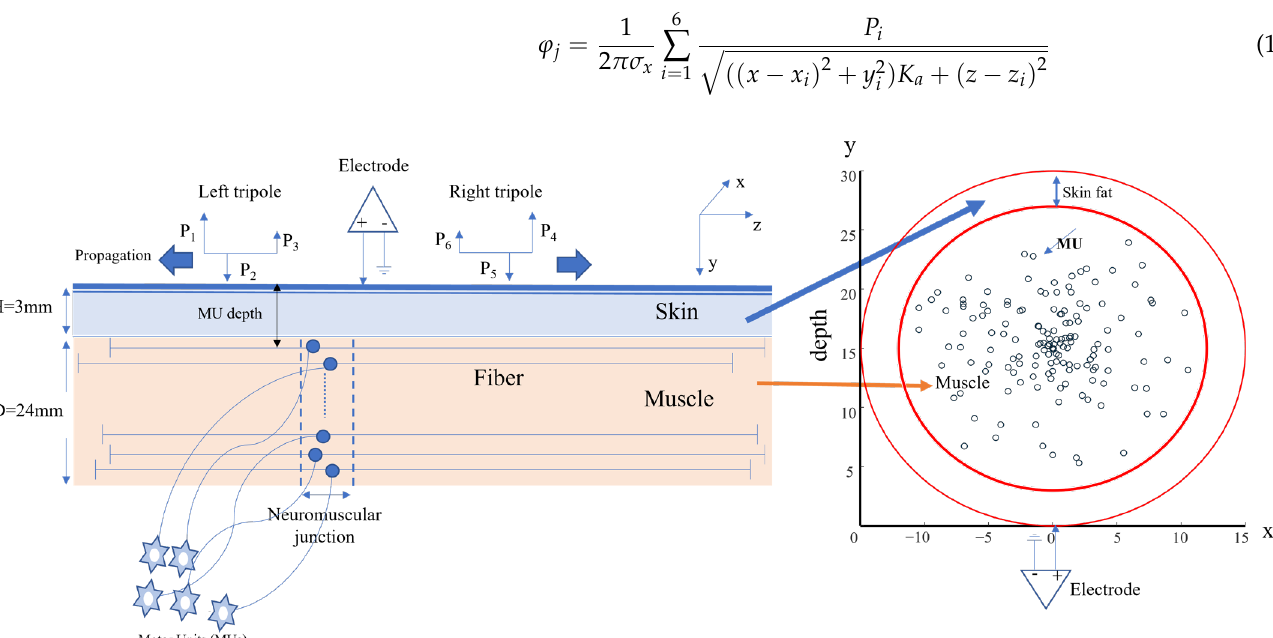
Figure 1. The cylindrical muscle model and electrode for surface EMG simulation. Left panel: the tripole model and the position of the electrode with respect to the cylinder parameters. Right panel: the cross-section of the cylindrical model showing muscle and skin fat layers.